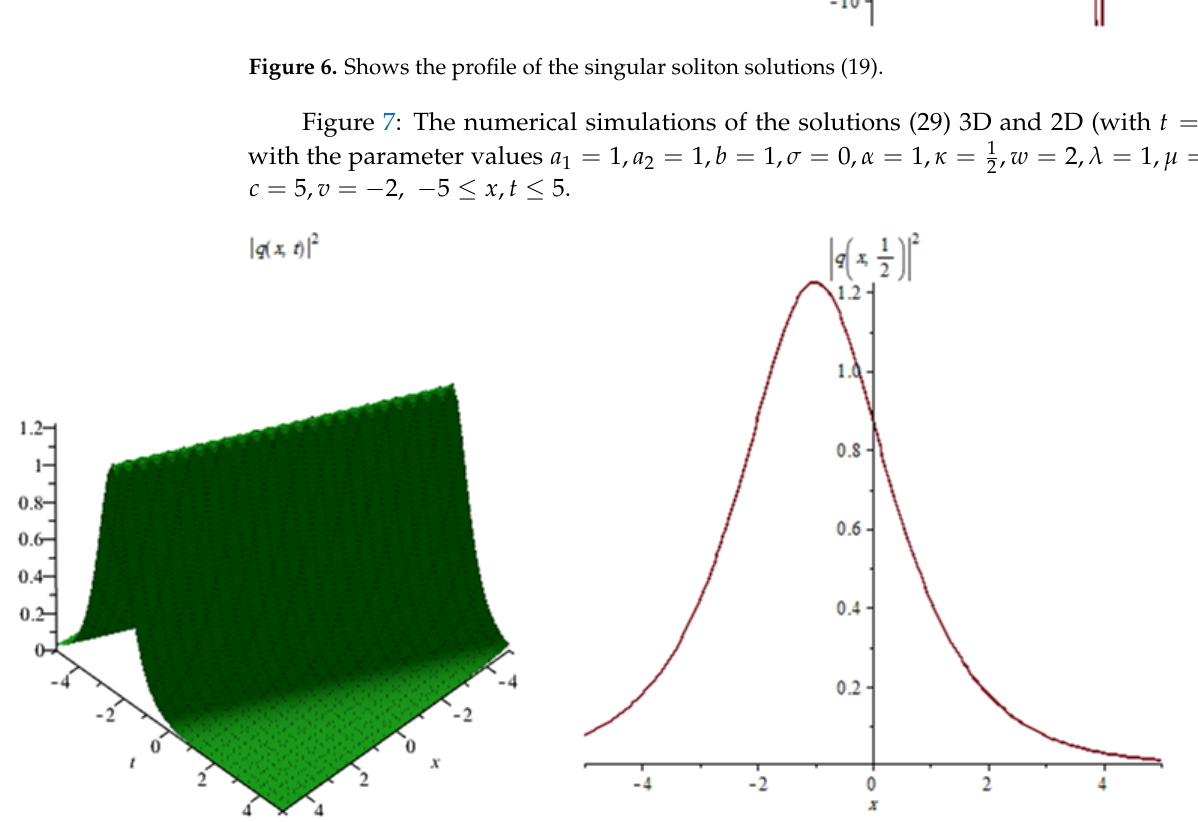
Figure 7. Shows the profile of the bright soliton solutions (29). Figure 8: The numerical simulations of the solutions (29) 3D and 2D (with t = 1 the parameter values a 1 = 1, a 2 = 1, b = 1, σ = 4, α = 4, κ = 1 6, 5 c = 10, v = x , t − − ≤ ≤